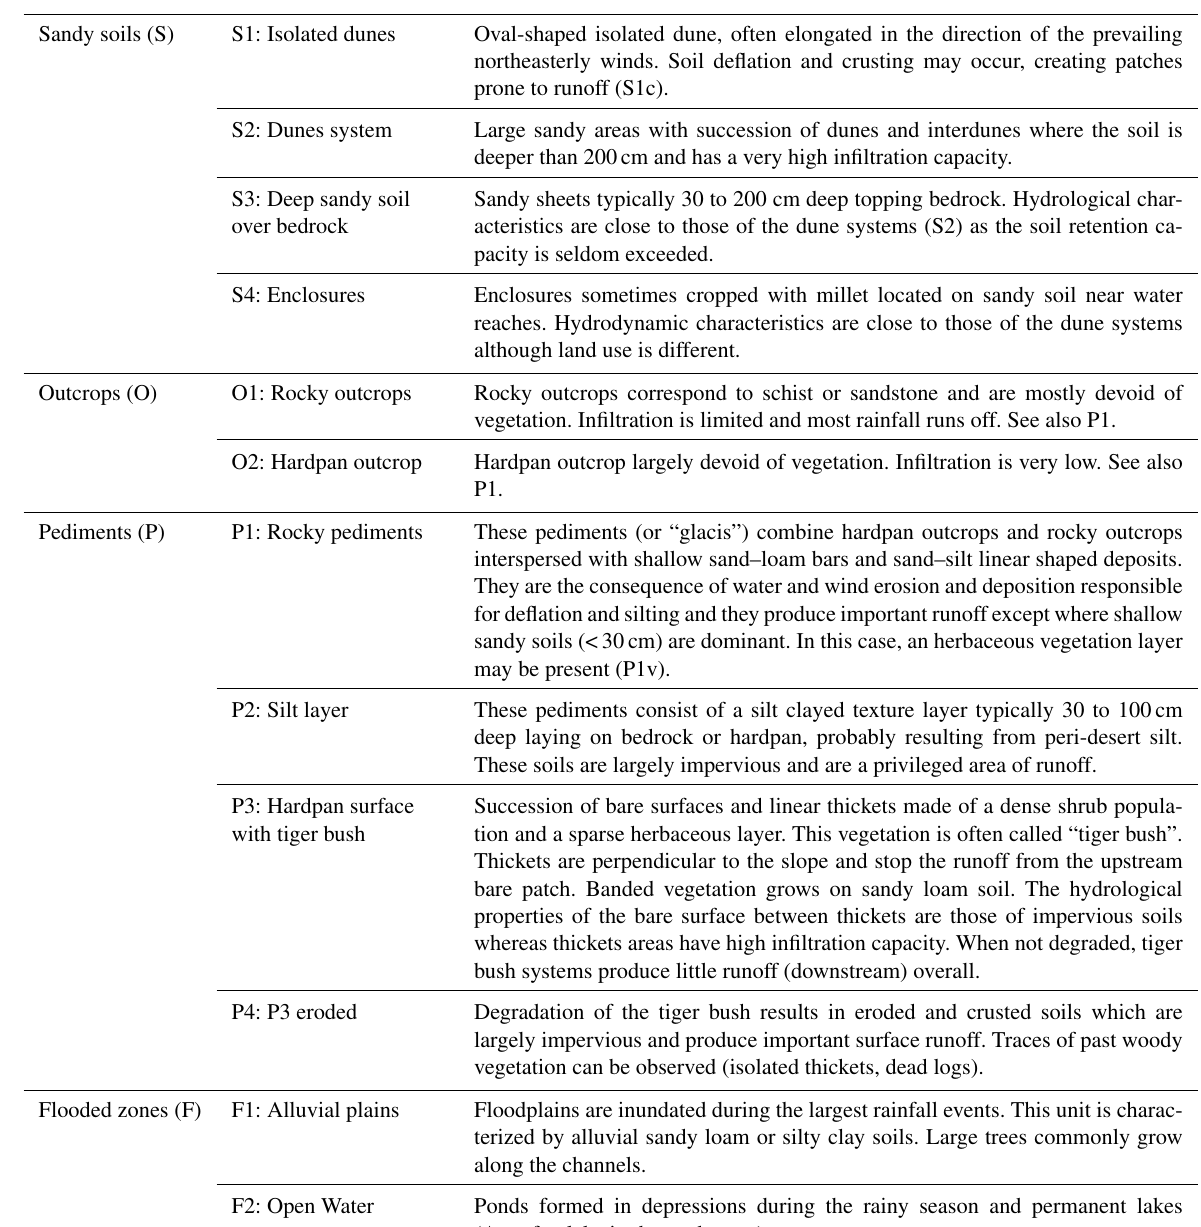
Table 2. Characteristics of the landscape units (soil and land cover type and hydrological properties). Sandy soils